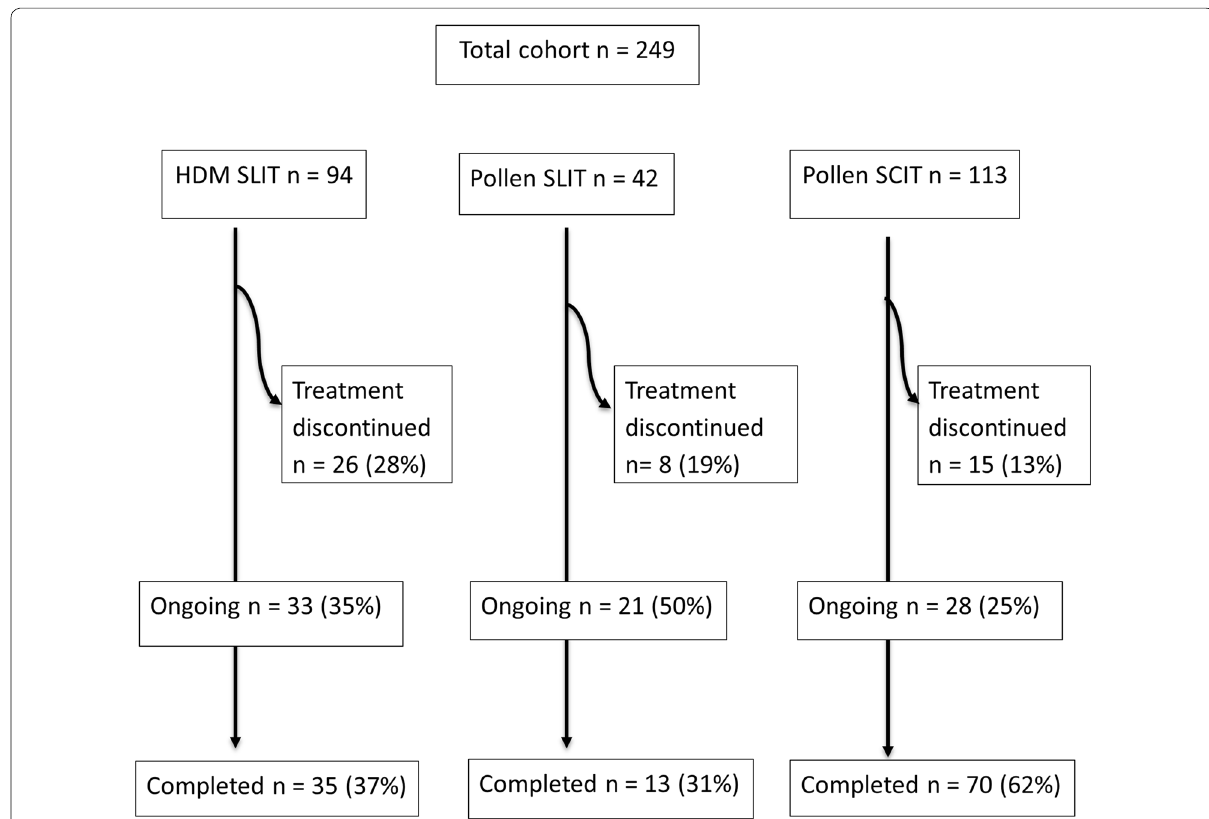
Fig. 1 Flow diagram showing the number (percentage) of children treated with HDM SLIT, pollen SLIT or pollen SCIT who completed the full 3 years, discontinued therapy prior to 3 years, or have ongoing